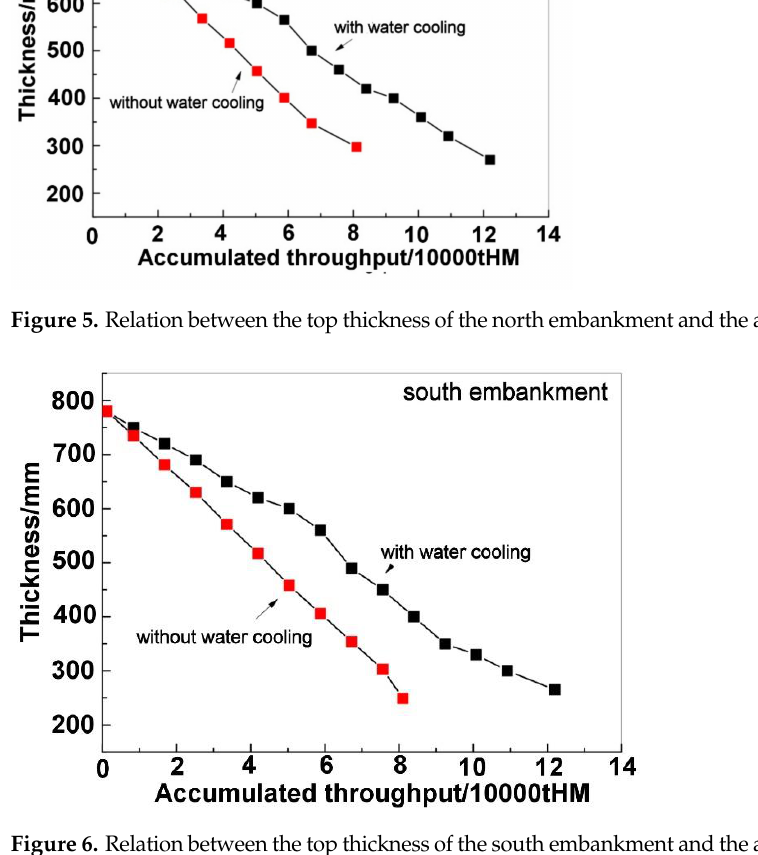
Figure 6. Relation between the top thickness of the south embankment and the accumulated throughput.